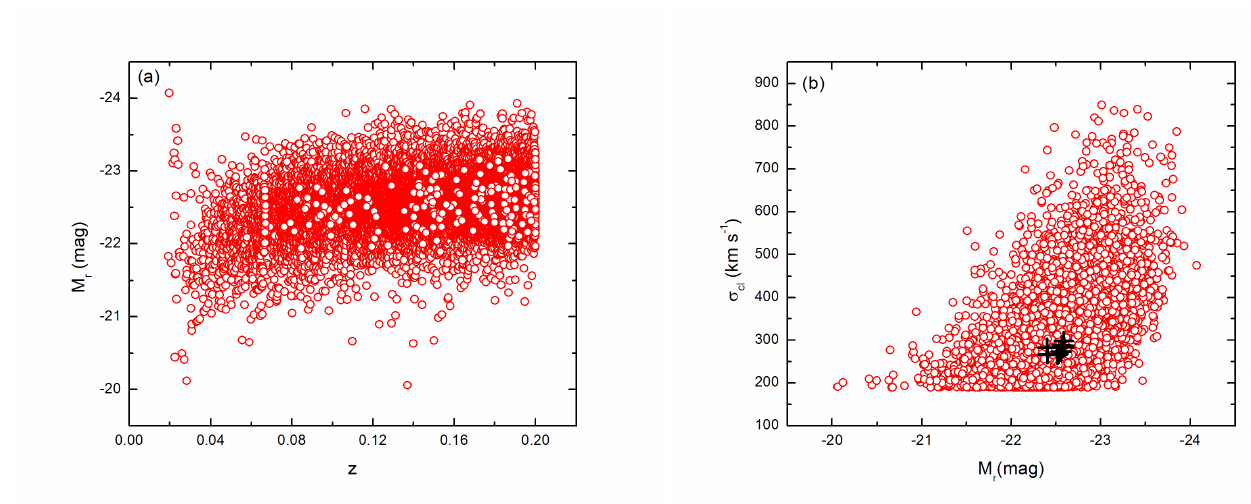
Fig. 4 BCGs r -band absolute magnitude with respect to (a) redshift and (b) σ cl of host clusters and groups. Error bars represent the average values of σ cl in every M r bin with errors.